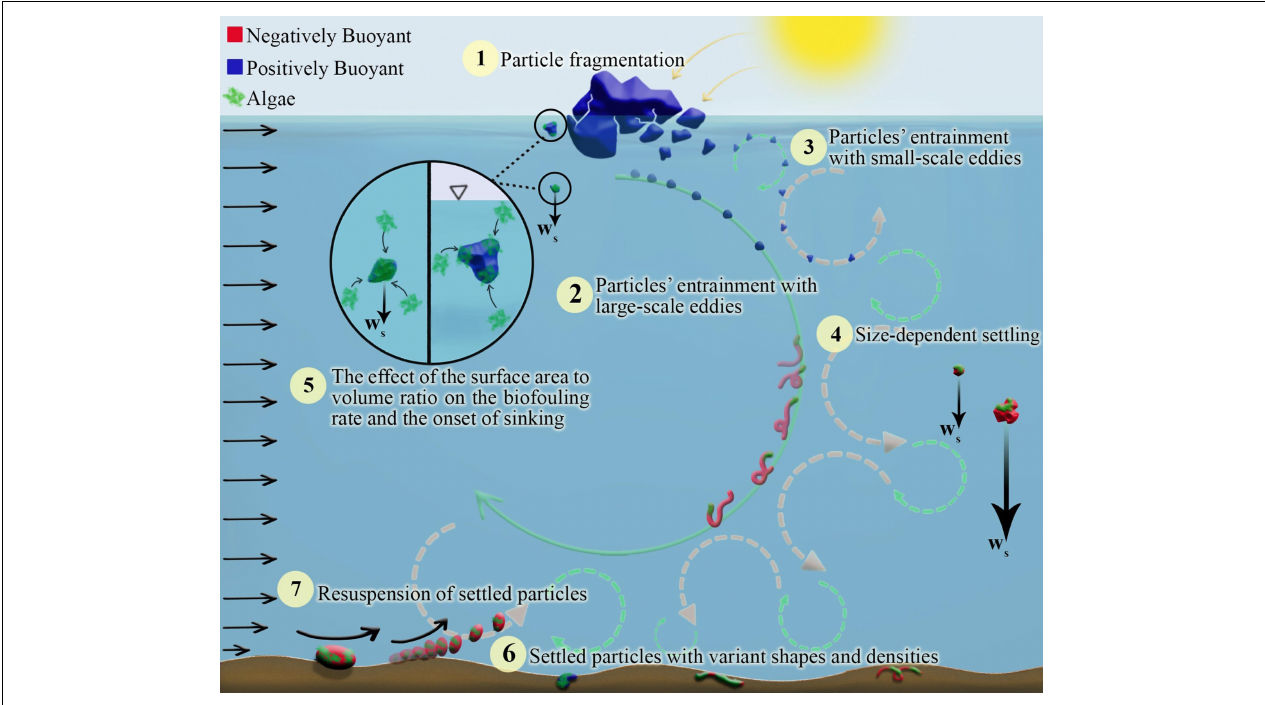
FIGURE 2 | Schematic representation of MP size linkage to different processes: from entrainment and sinking to resuspension. In this figure, MPs of different shapes are illustrated, where red and blue colors present negatively and positively buoyant plastics,